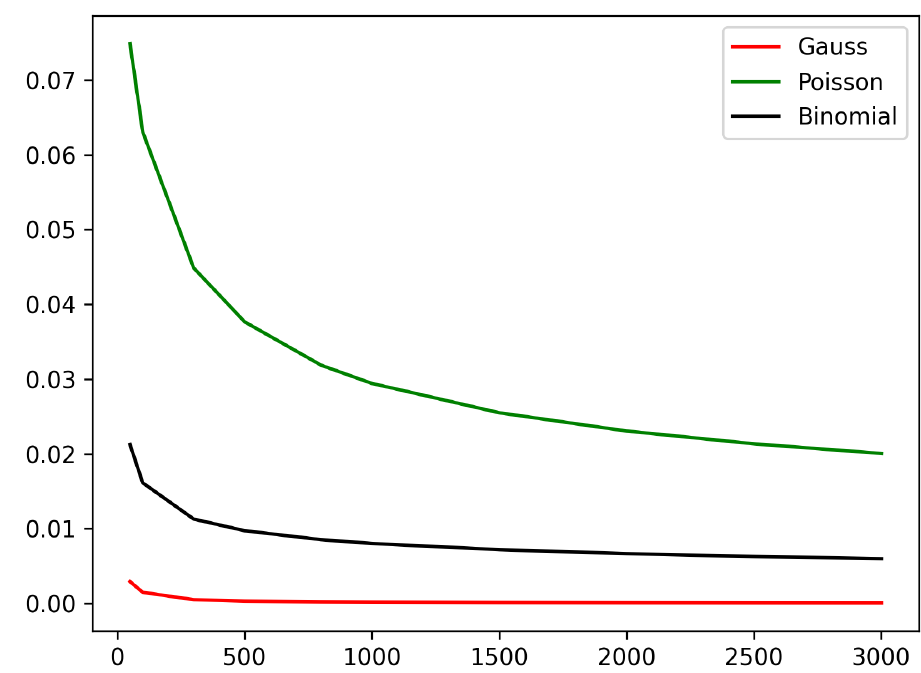
Figure 3. Total variational distance between the approximated and the exact degree distribution in the function of network size when the IRGs are generated by Range parametrization of the biased static edge voting